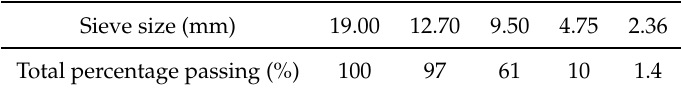
Table 1. Gradation of the coarse aggregate [5].